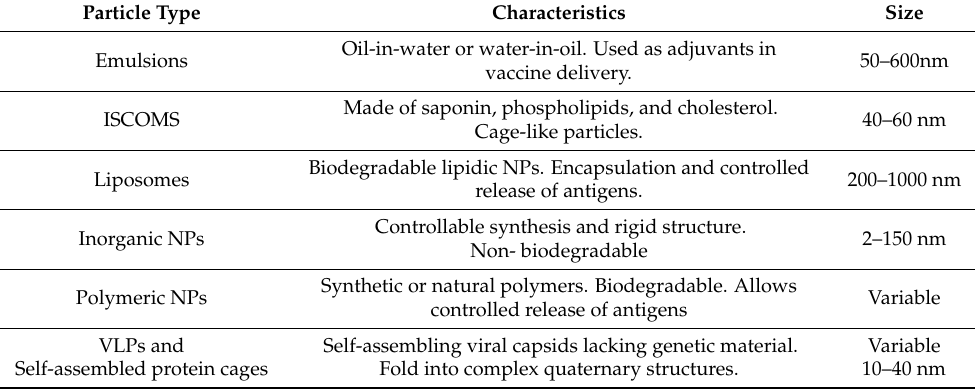
Table 1. Summary of the six types of nanoparticles used in vaccine development, their main charac- teristics and